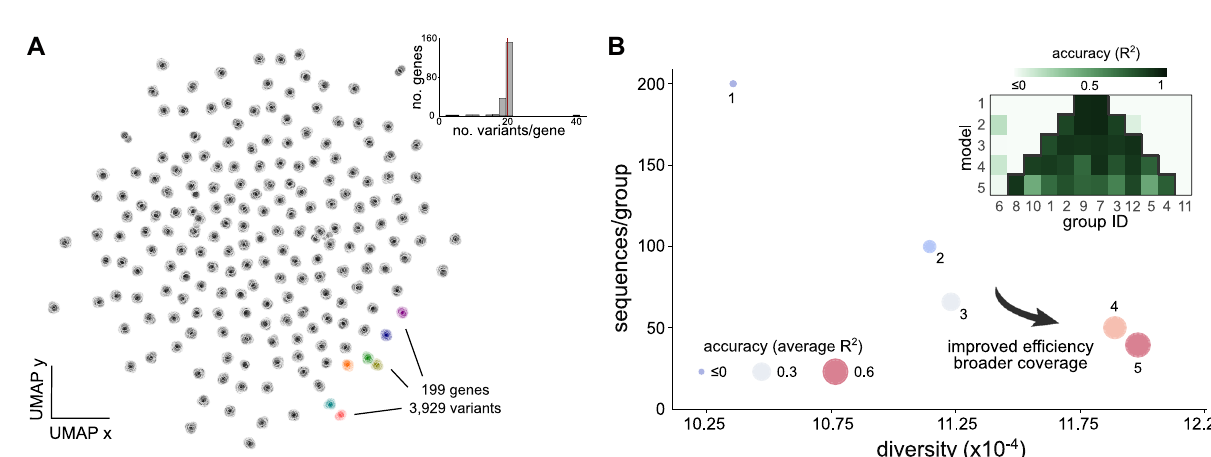
Fig. 5 | Impact of sequence diversity on data ef fi ciency and model coverage. A WetrainedCNNsondatasetsofconstantsizeandincreasingsequencediversity. We trained a total of 27 modelsby successively aggregating fractions ofrandomly chosen mutational series into a new dataset for training; the total size of the training was kept constant at 5800 sequences. Training on aggregated sequences achieves good accuracy for mutational series in the training set, but poor predic- tions for series not included in the training data. This suggests that CNNs gen- eralize poorly across unseen regions of the sequence space. Accuracy is reported as the R 2 computed on 10% held-out sequences from each mutational series. We excludedtwoseriesfromtrainingtotestthegeneralizationperformanceofthelast model. B Bubble plot showsthe R 2 values averagedacross all mutational seriesfor